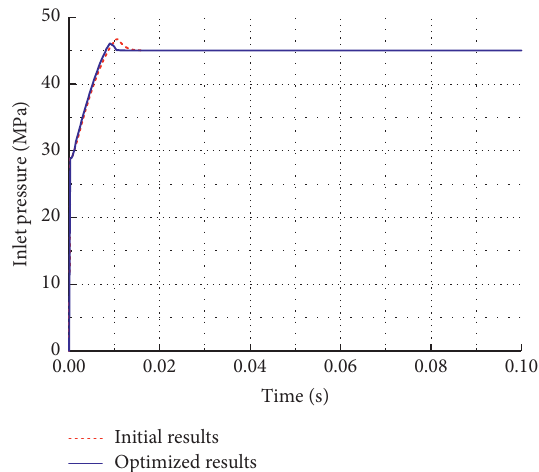
Figure 20: Comparison between initial results and optimized results.